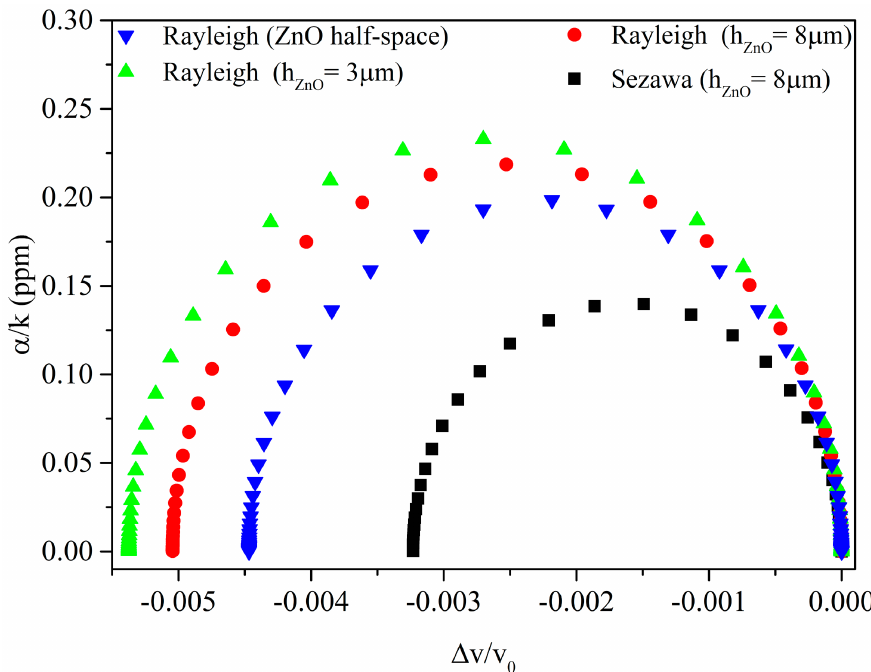
Figure 5. The α / k vs. the relative phase velocity curves for the Rayleigh wave in ZnO half-space Figure 5. The relative phase velocity vs. the α / k curves for the Rayleigh wave in ZnO half-space (blue dots), SiO 2 /ZnO (green and red dots for ZnO layer 3 and 8 µ m thick), and for the Sezawa wave (blue dots), SiO 2 /ZnO (green and red dots for ZnO layer 3 and 8 µm thick), and for the Sezawa wave (black dots) in SiO 2 /ZnO (8 µ m), the Al conductivity being the (black dots) in SiO 2 /ZnO (8 µm), the Al conductivity being the parameter. The Sezawa wave in ZnO/SiO 2 (black dots) has a K 2 (0.89%) lower than that of the